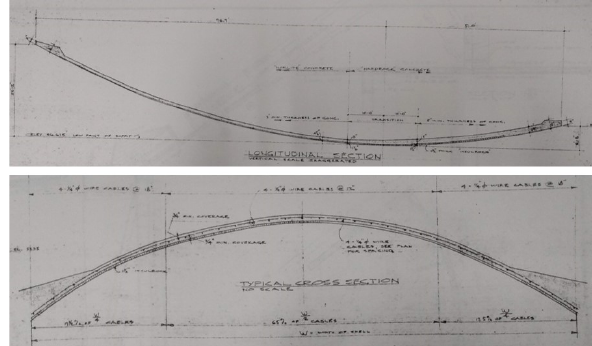
Figure 6: Orthogonal longitudinal shell sections designed as arches